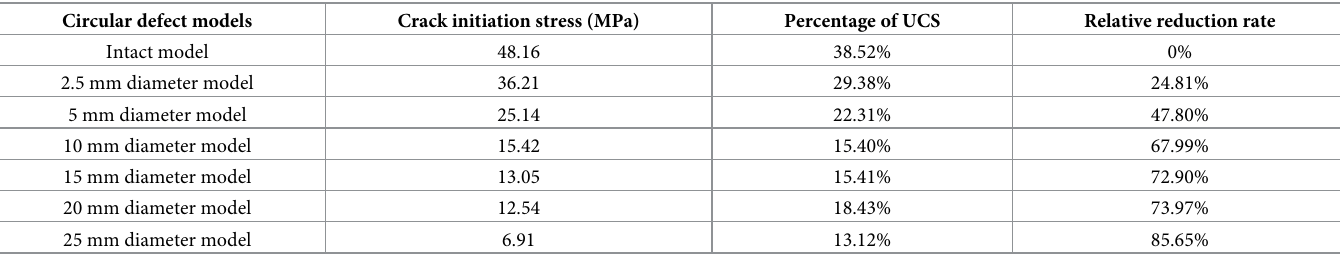
Table 3. Crack initiation stress value, percentage of the UCS, and the relative reduction rate. Circular defect